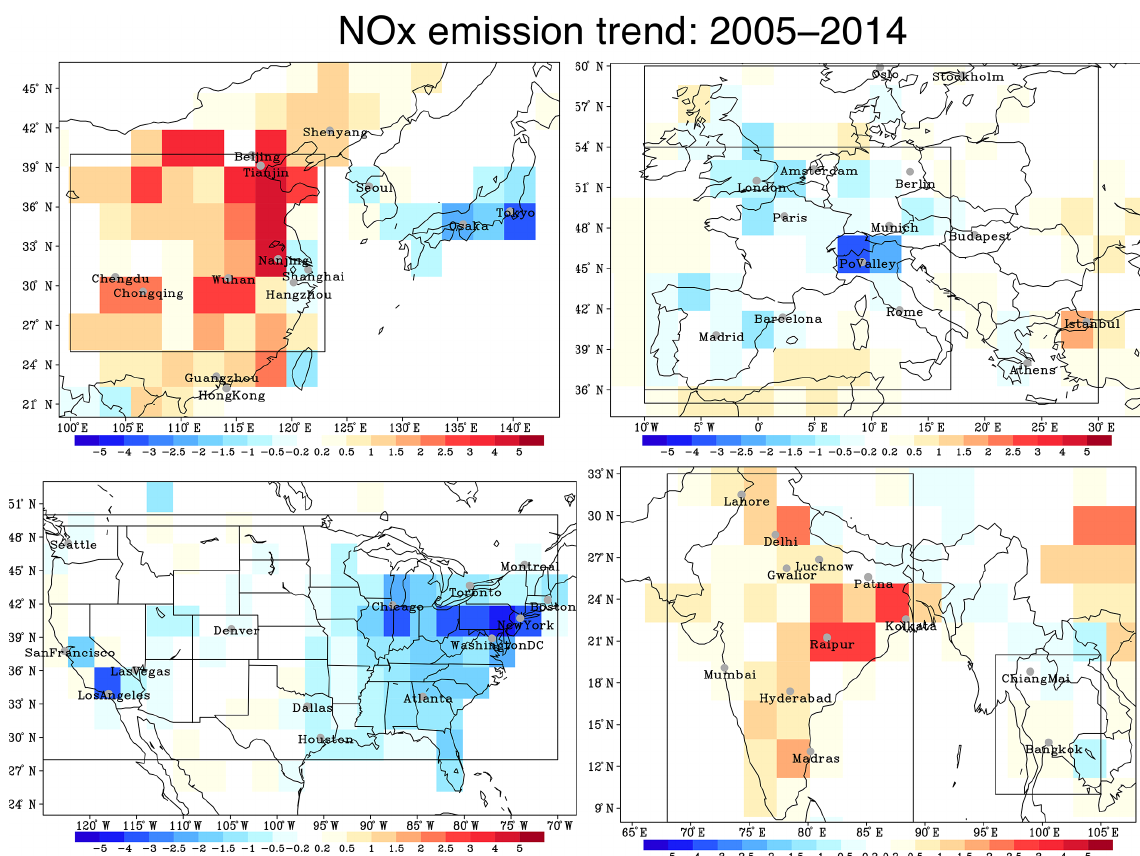
Figure 12. The regional distribution of the linear trend in surface NO x emissions (in 10 − 11 kgm − 2 s − 1 per decade) during 2005–2014 over East Asia (upper left panel), Europe (upper right panel), the USA (bottom left panel), and South-east Asia (bottom right panel), obtained from the a posteriori emissions. The black square line represents the region used for the regional mean